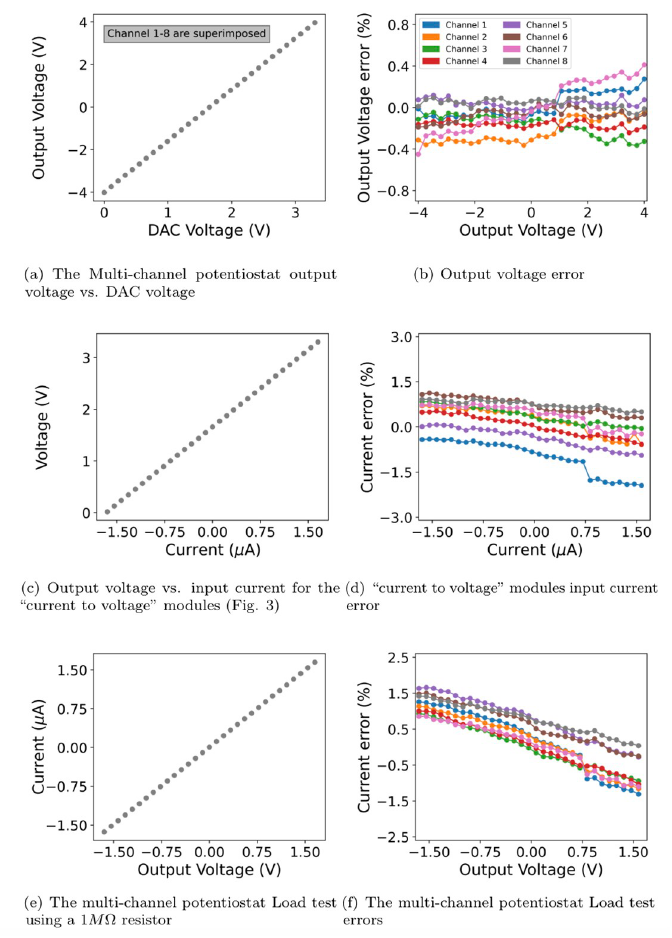
Fig 3. The multi-channel potentiostat characterization tests for channels 1 to 8. (A) The measured output voltage on channels 1 to 8 (-4 to +4 V and a resolution of 1.95 mV) as a function of the DAC voltage. (B) Output voltage error. (C) The output voltage as a function of the input current (-1.65 to +1.65 μA ) for the “current to voltage” converter modules shown in Fig 4 (D) Input current errors on the “current to voltage” modules (E) multi-channel potentiostat Load test. The current passing through a 1 M O resistor is monitored during a multi-channel potentiostat voltage sweep (-1.65 to +1.65 V) (F) Current errors during the load test.